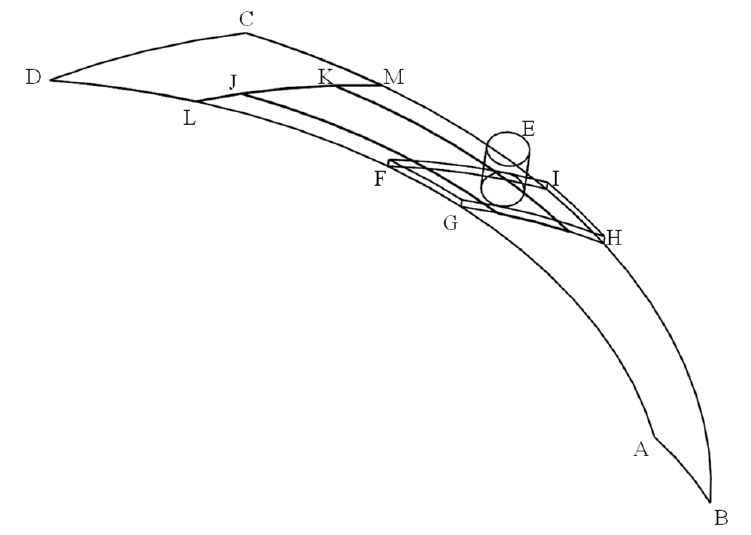
Figure 3. Computational region of the flow.